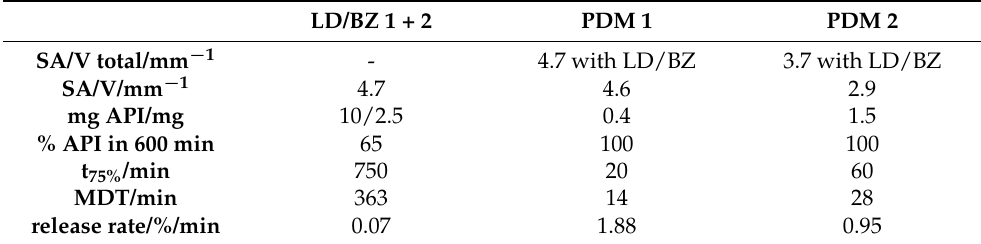
Figure 12. ( Left ): release profile of MiniHCwC 1 ( top ) and 2 ( bottom ); modified basket apparatus, 1000 mL 0.1 N HCl, 50 rpm, 37.0 ± 0.5 ◦ C, x ± s; n = 3. ( Right ): Image of MiniHCwC1 + 2: red: PDM-PVA, blue: LD/BZ-EVA. Table 11. Structure and release properties of MiniHC with a cross.